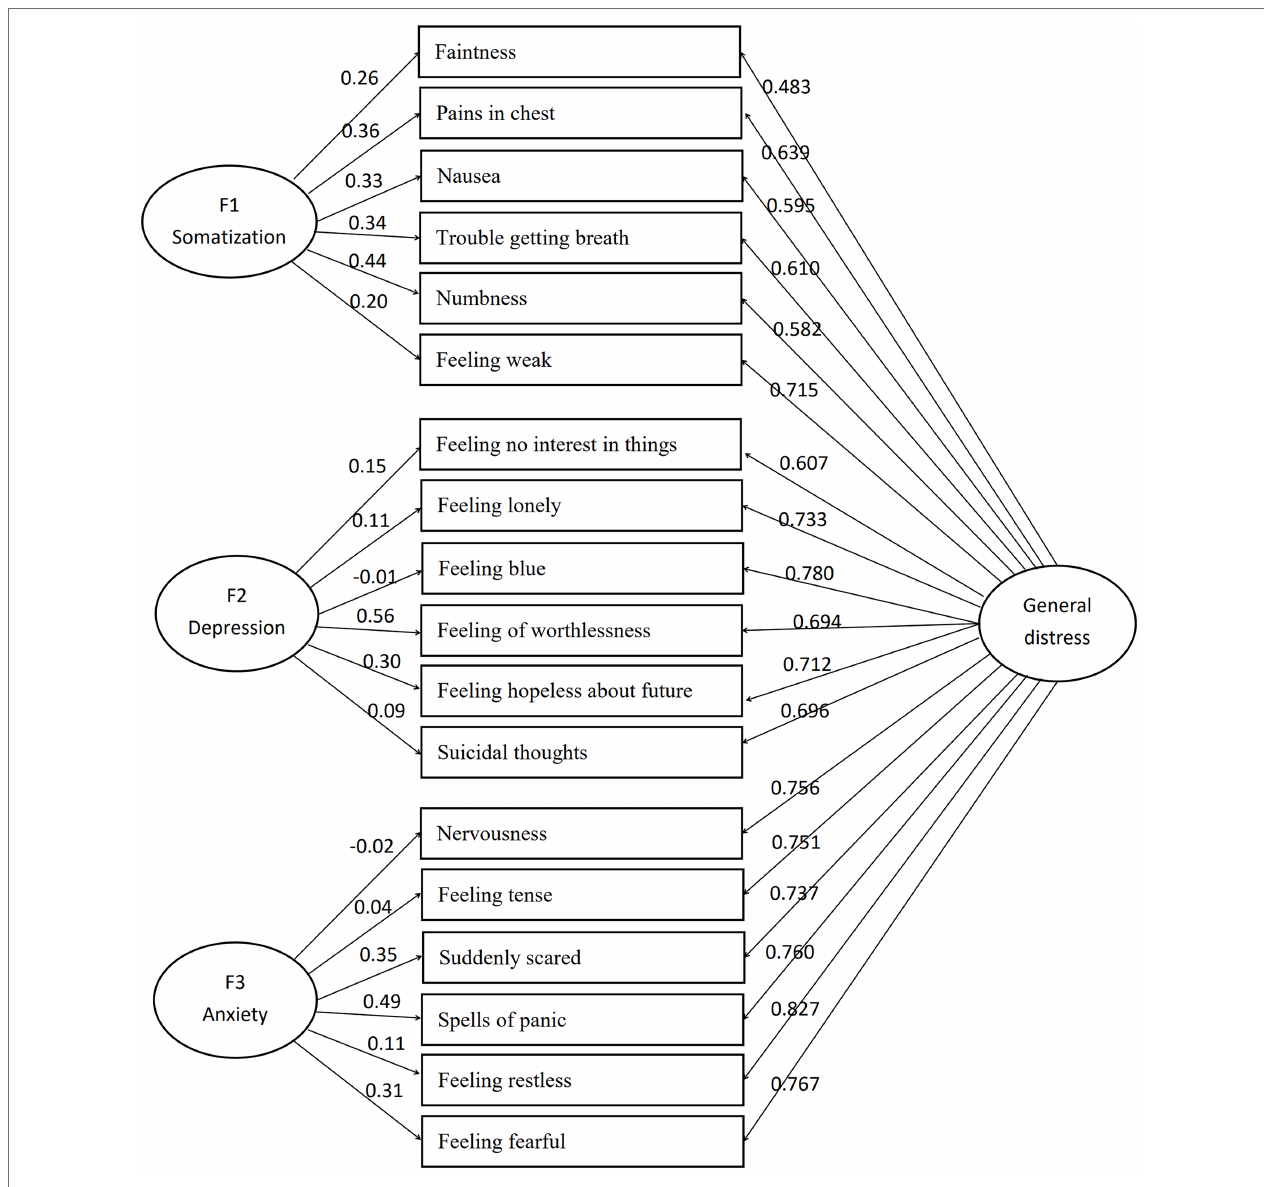
FIGURE 1 | Structural model of three-factor bi-factor